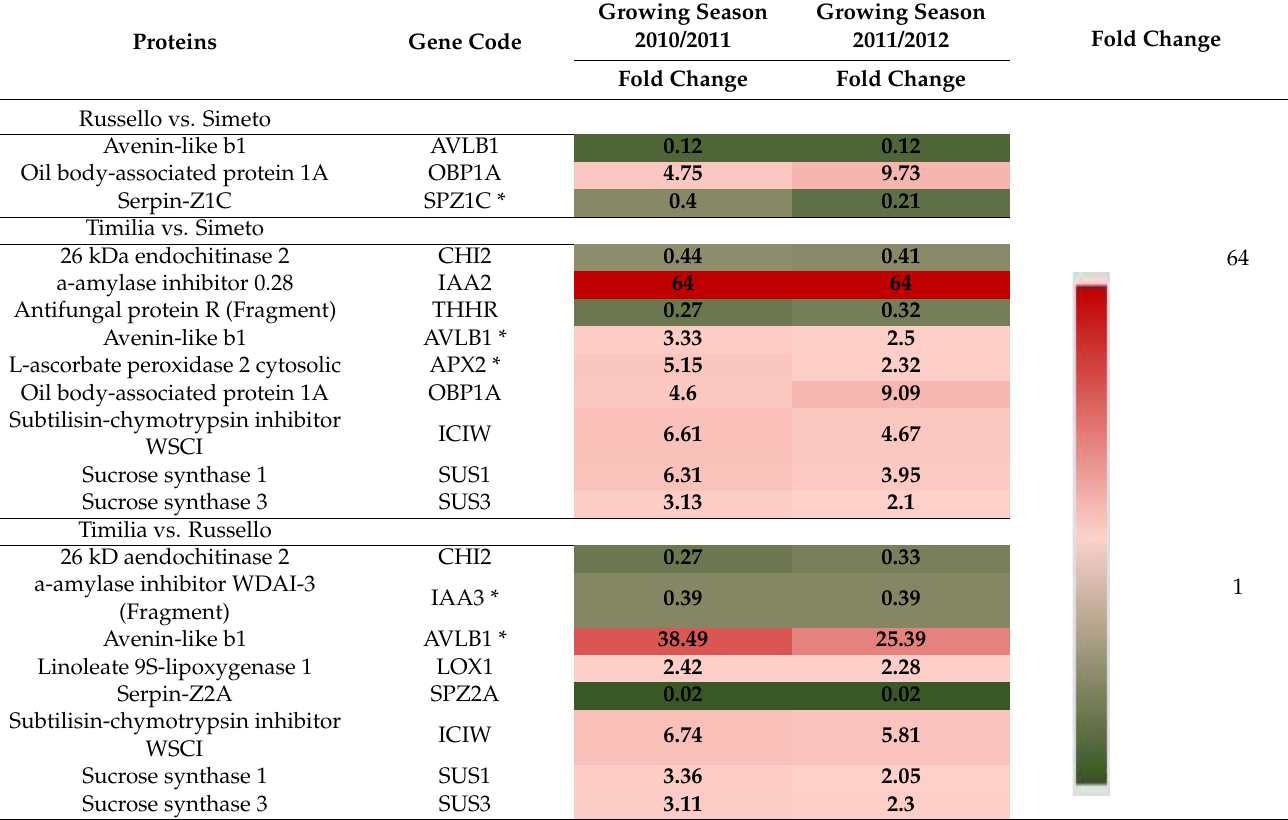
Figure 1. Pie chart showing the distribution of biological processes in which are involved the dif- ferential abundant proteins observed across the investigated